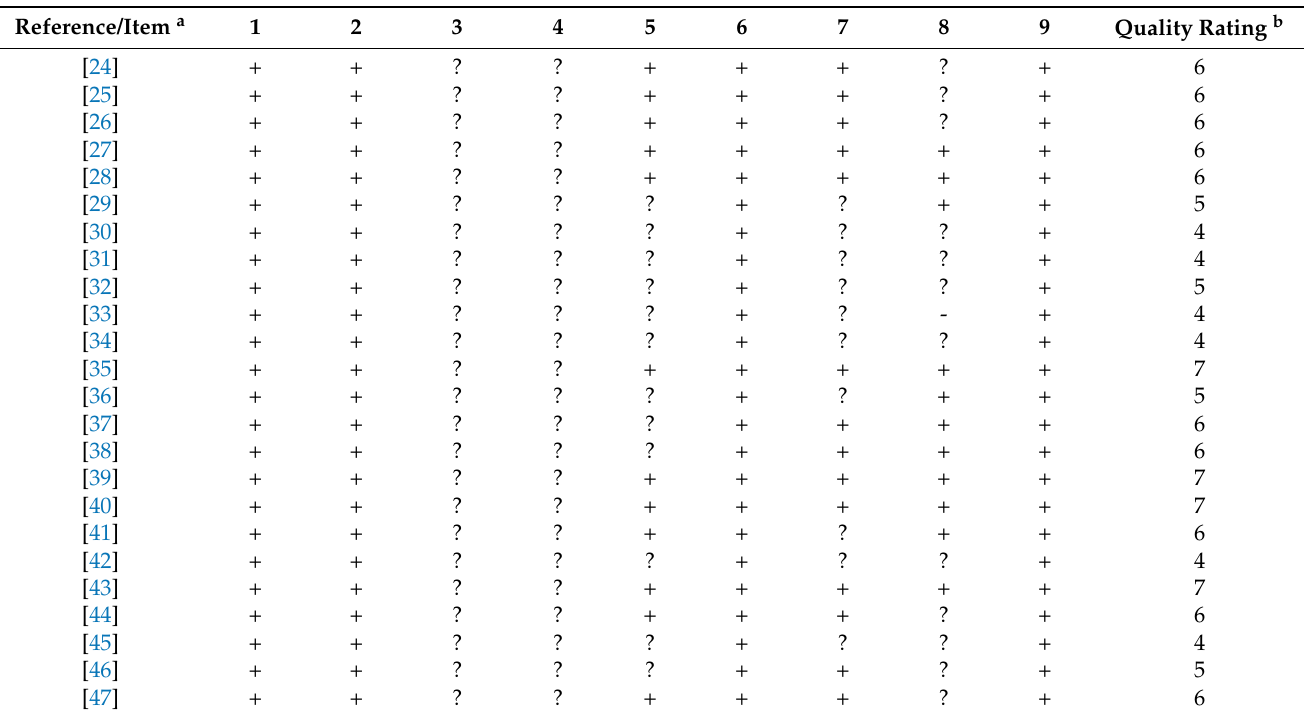
Table 2. Methodological quality assessment for studies published on BMI and COVID-19 according to the criteria of the National Heart, Lung and Blood Institute